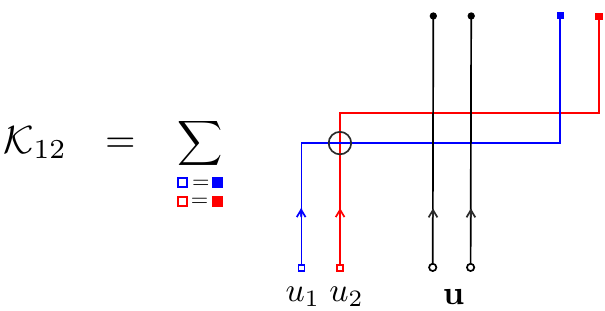
Figure 16 . For the scattering kernel, two probe rapidities u 1 ; u 2 are scattered with one another, carried through the Bethe state u and scattered back to their original positions. We identify the incoming and outgoing probe states and sum over all the (cid:13)avors. The circle around the (cid:12)rst scattering event indicates that a derivative w.r.t. u 1 is taken at this interaction